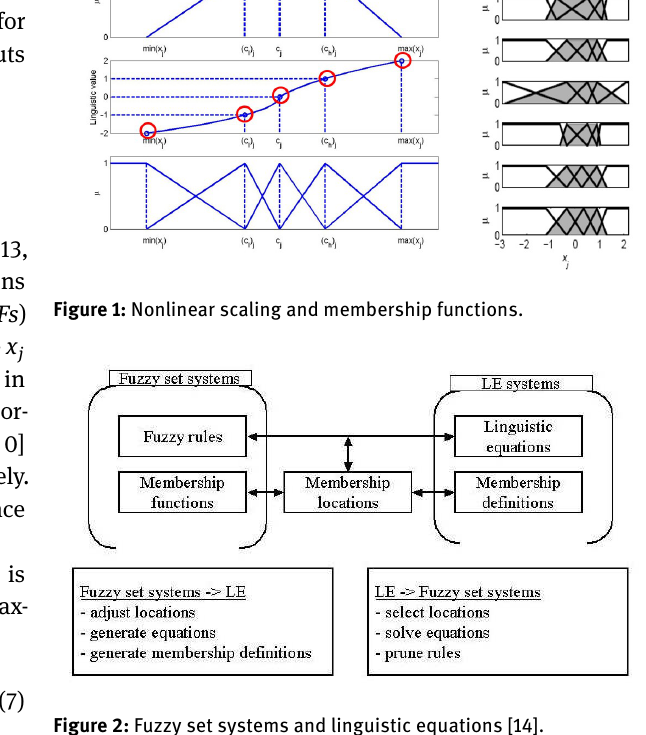
Figure 2: Fuzzy set systems and linguistic equations